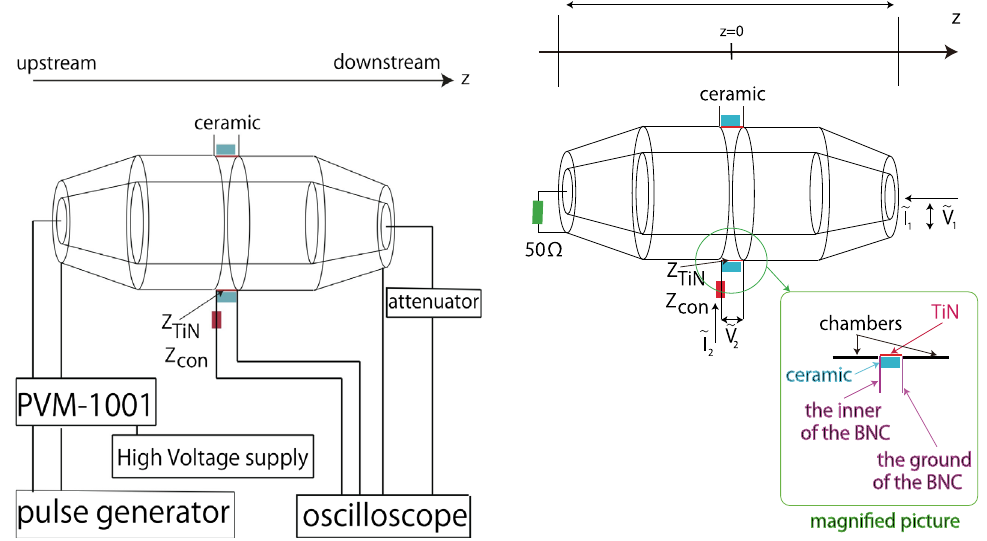
FIG. 3. Schematic of the measurement setups in the time domain (left) and the frequency domain (right), to observe the relation between the voltage on the ceramic break and the pulse current on the inner